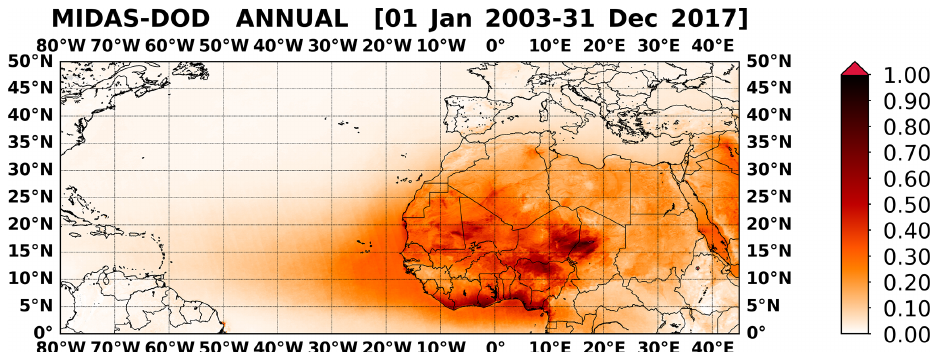
Figure 1. Geographical distribution of the MIDAS annual DOD at 550nm, representative for the period 1 January 2003–31 December 2017, over North Africa, the tropical Atlantic Ocean and the broader Mediterranean Basin.